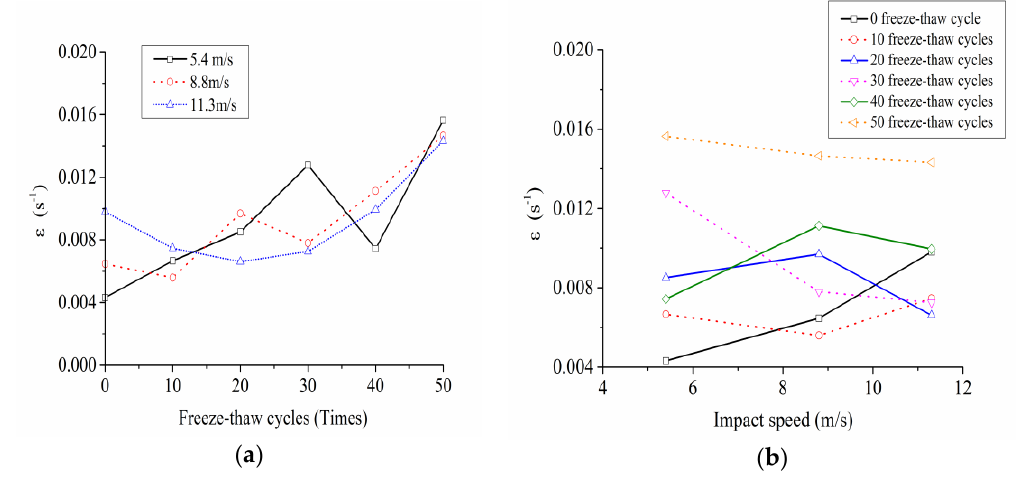
Figure 7. Variation rules of dynamic peak strain with freeze-thaw cycles and impact loading speed. ( a ) Variation rules of dynamic peak strain with freeze-thaw cycles; ( b ) variation rules of dynamic peak strain with impact loading speed.